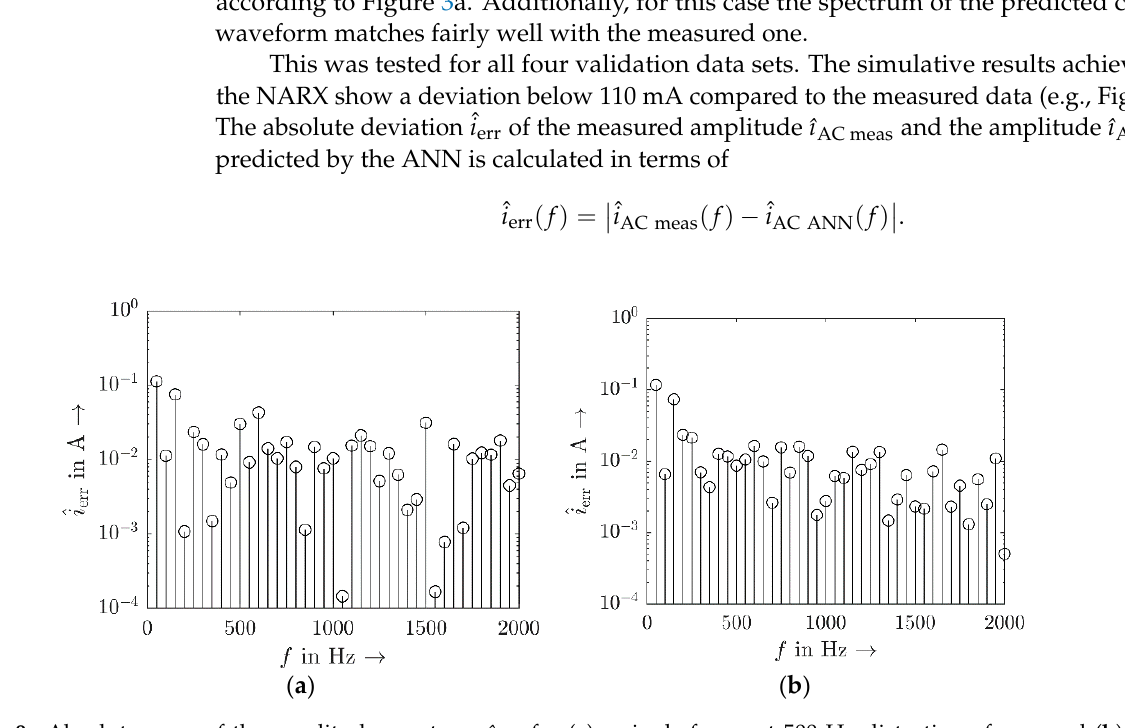
frequent distortion of u AC. multi-frequent distortion of u